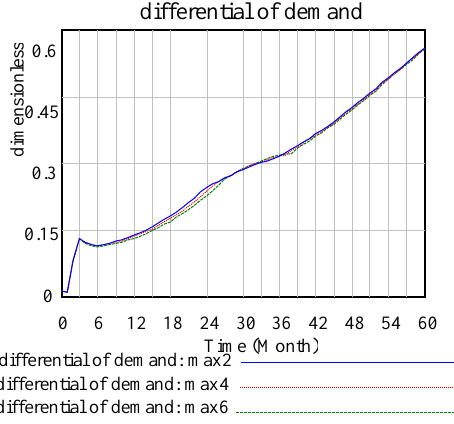
Figure 10. Di ff erential Figure 10. Differential demand. Figure 10. Differential demand.